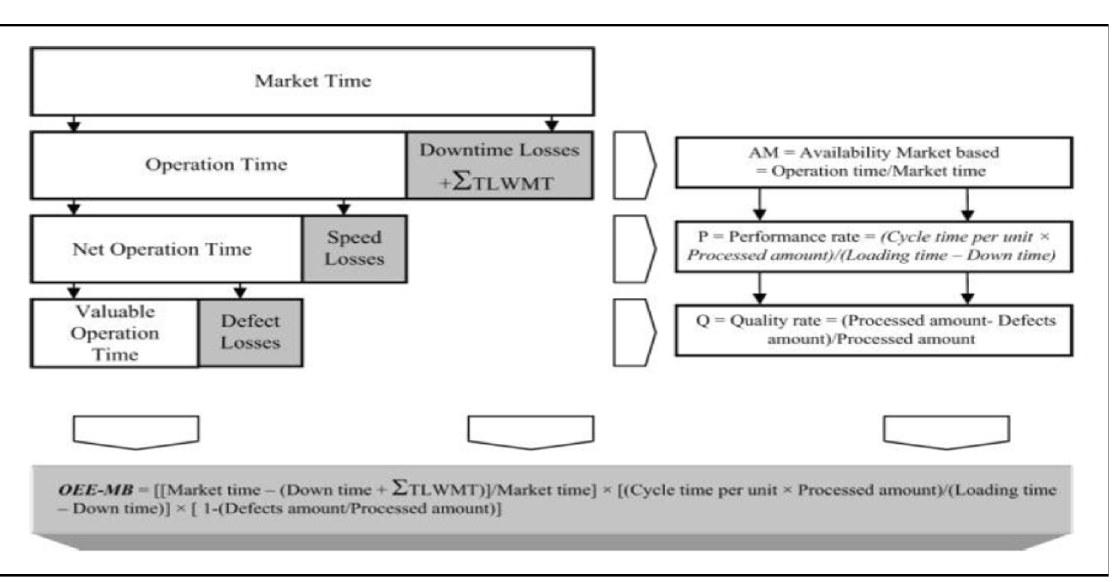
Figure 2. The concept of OEE-MB and the relationship between elements (Anvari et al.,